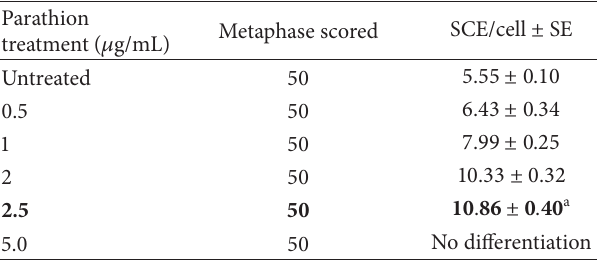
Figure 5: Simultaneous effects of curcumin and carvacrol in SCE assay in human lymphocytes against parathion. ∗ P: parathion, Cu: curcumin, and Ca: carvacrol. Table 1: Frequency of SCE/cell in cultured human lymphocytes treated with parathion.